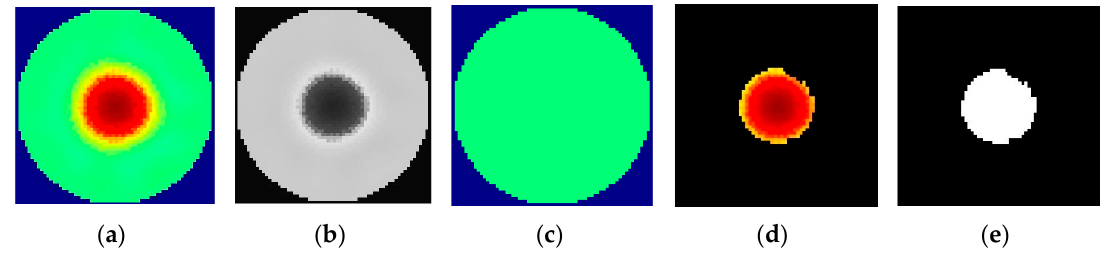
Figure 8. Image Processing Scheme: ( a ) Original image ( b ) Grayscale image ( c ) Background ( d ) Foreground ( e ) Segmented image. ( d ) Foreground ( e ) Segmented image.